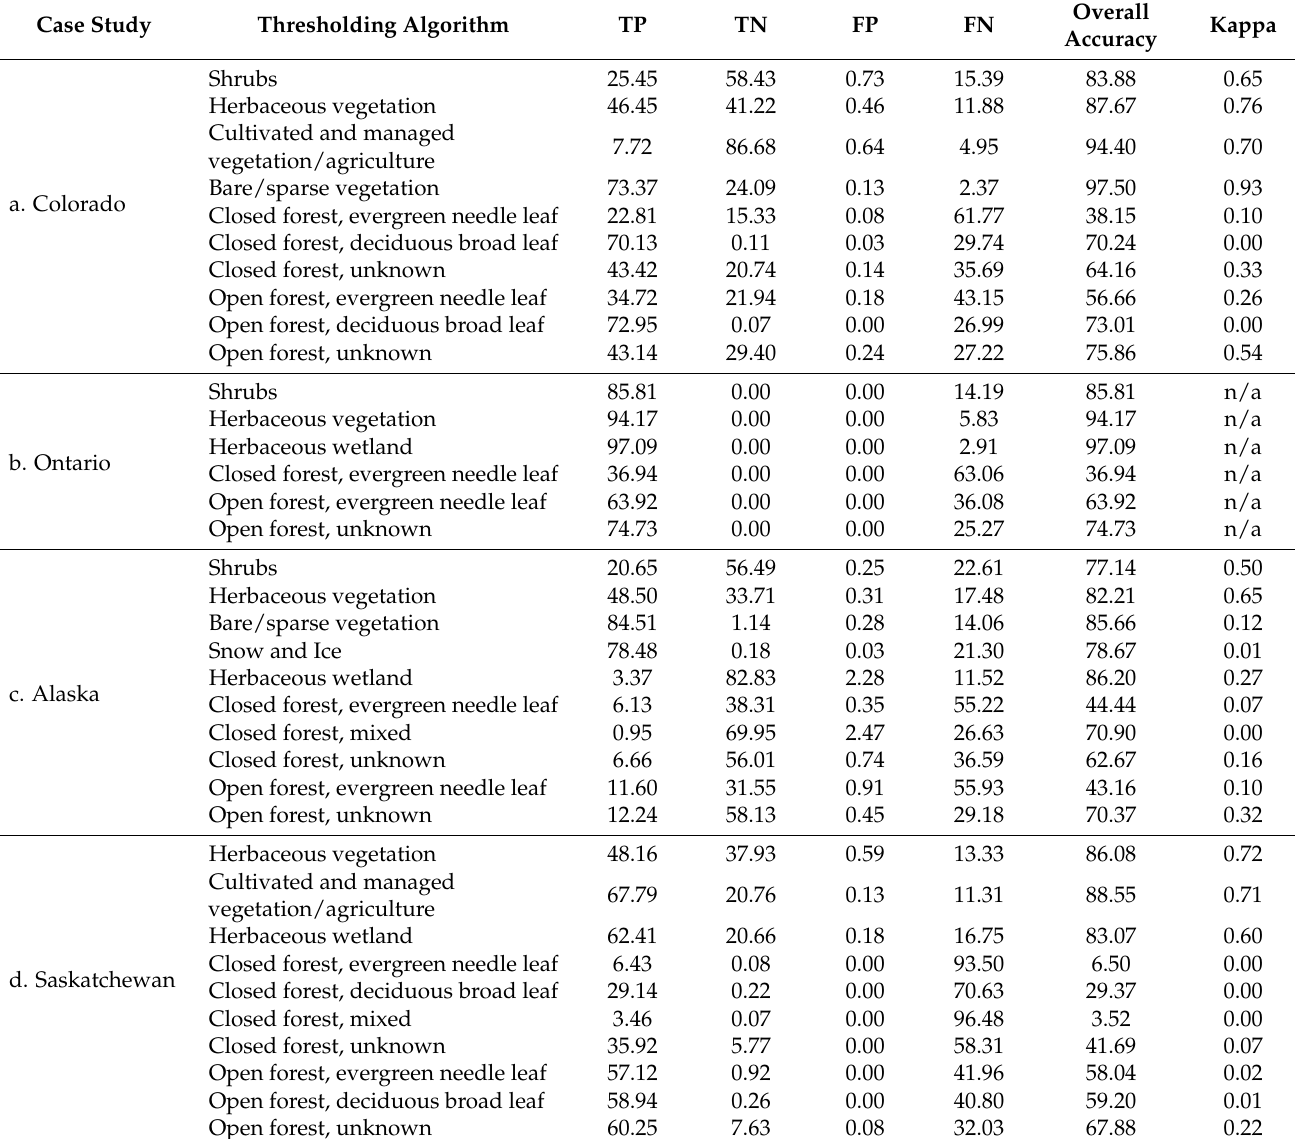
Table 4. Confusion matrix per land cover type for the four case study